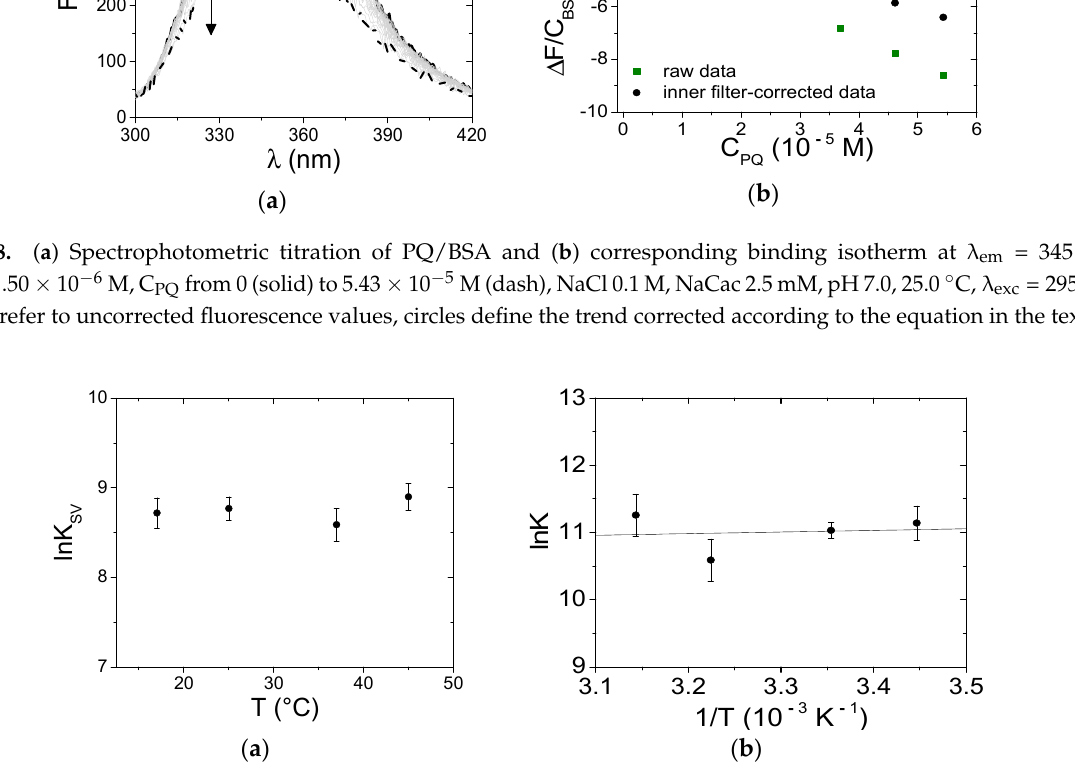
Figure 9. Dependence on temperature of ( a ) the Stern–Volmer constant K SV and ( b ) the binding constant K for the PQ/BSA system; NaCl 0.1 M, NaCac 2.5 mM, pH 7.0.